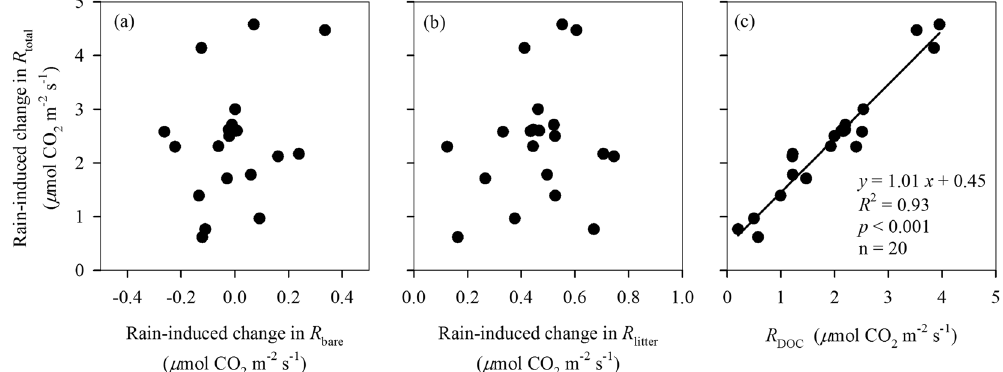
Figure 4. Relationships of rain-induced changes in soil CO 2 fluxes among different CO 2 sources. R total , R bare , R litter , and R DOC , represent total soil CO 2 flux, bare soil CO 2 flux, litter CO 2 flux, and litter DOC-contributed CO 2 flux, respectively.